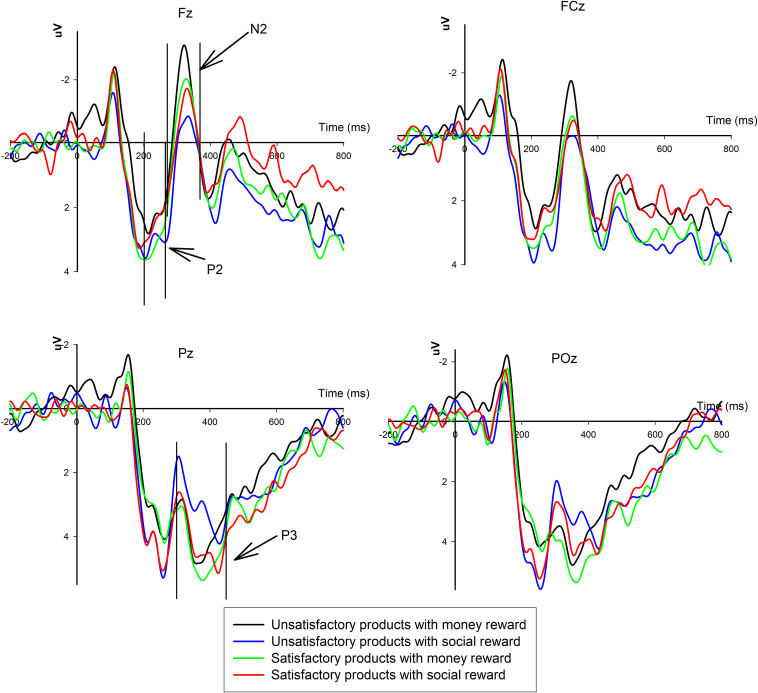
Event-related potentials grand-average waveforms elicited in response to different product customer satisfactions and reward types at channels Fz, FCz, Pz, and POz are presented.